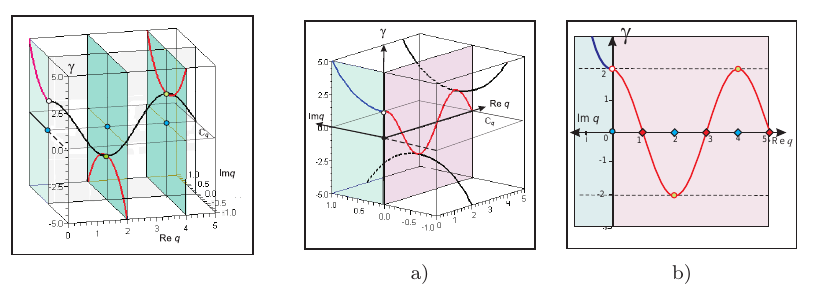
Figure 9. a) Complex-real characteristic function for Figure 8. Complex-real cha- real eigenvalues in the case ξ = 1 / 2 . b) The graph of the racteristic function for com- real characteristic plex and negative eigenvalues in the case ξ = 1 / 2 .